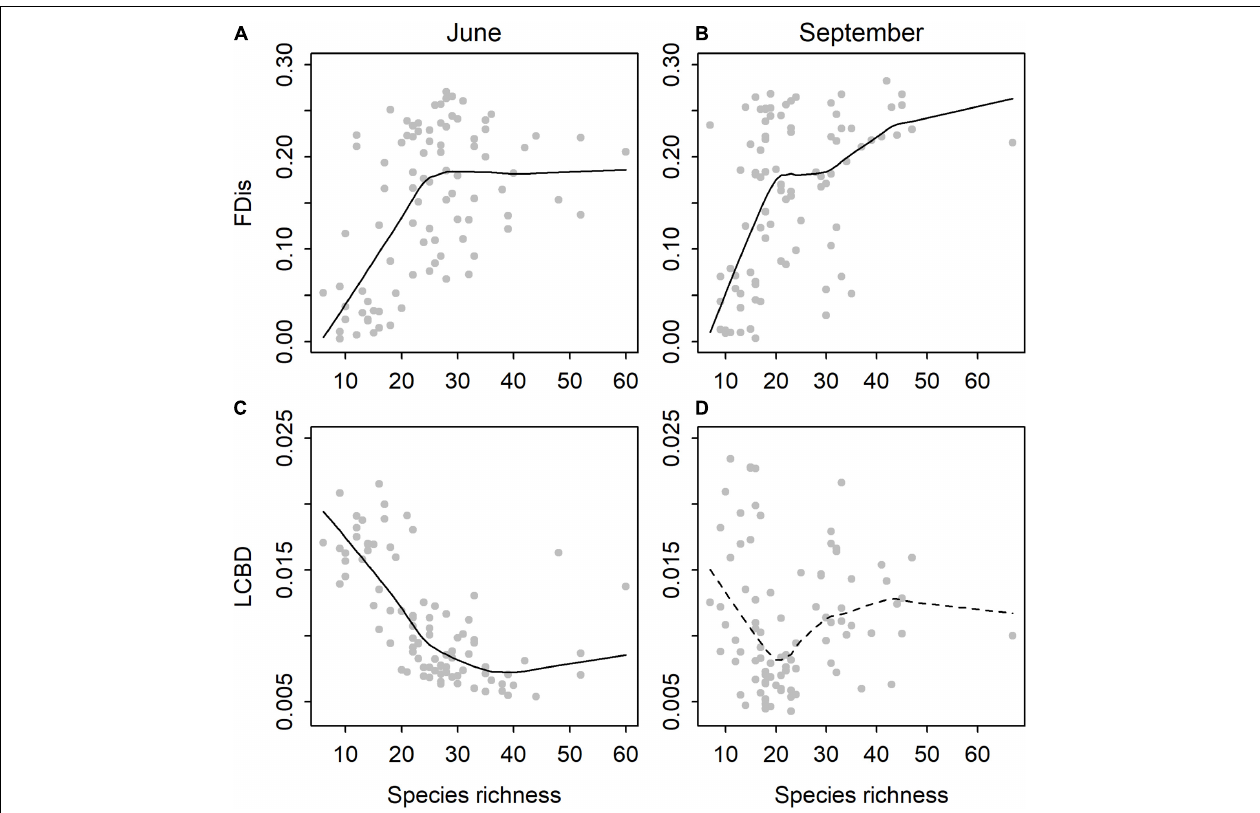
FIGURE 1 | Relationships between species richness and functional dispersion (FDis) in (A) June and (B) September, and between species richness and local contributions to beta diversity (LCBD) in (C) June and (D) September for diatoms among the rock pools ( n = 91).